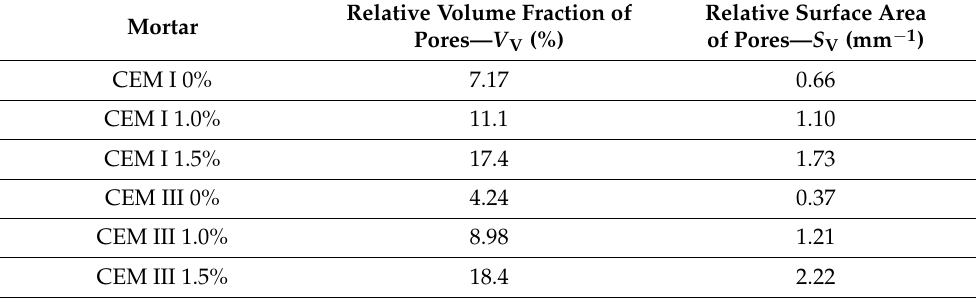
Table 4. Parameters of pore structure calculated by the computer image analysis